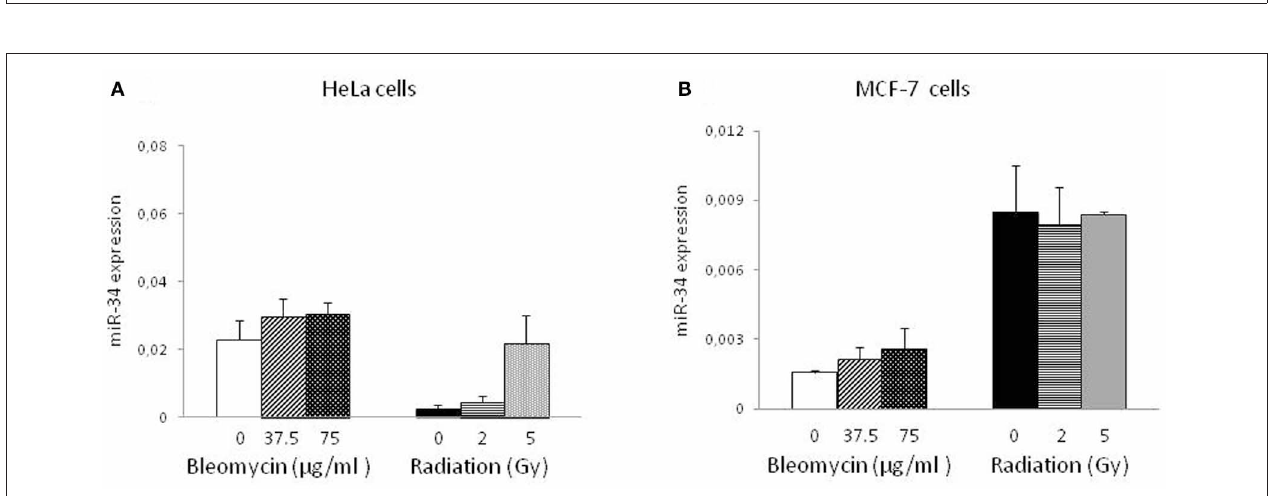
FIGURE 1 | Accumulation of p53 protein. Cytoplasmic lysates of BLM-treated and irradiated cells were used to quantitatively determine the accumulation of p53 protein ( A and B ) by ELISA. Results of three-independentcell culture experiments were evaluated to calculate the average value. BLM, bleomycin; Rad., radiation.